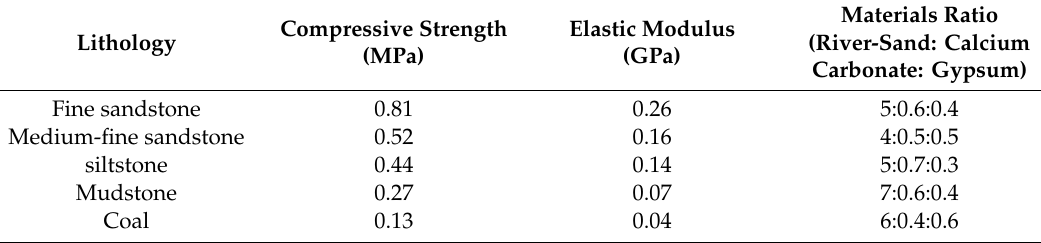
Table 2. The ideal mechanical parameters of similar materials and the materials